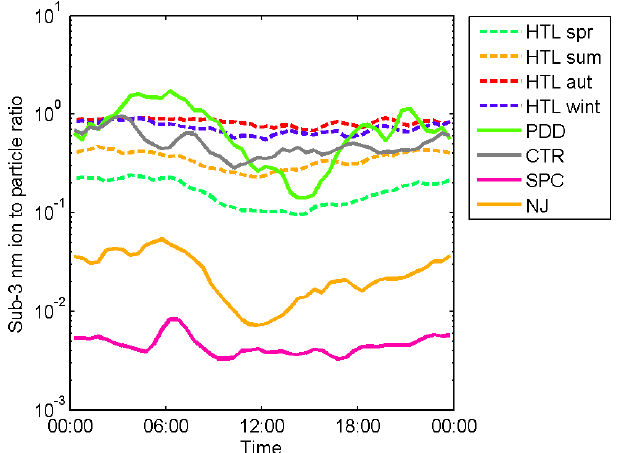
Figure 8. The median diurnal variation in the ratio of sub-3nm ion concentration to the total particle concentration during differ- ent measurement campaigns. The data from Hyytiälä (HTL) are di- vided into different seasons: spring (spr), summer (sum), autumn (aut), and winter